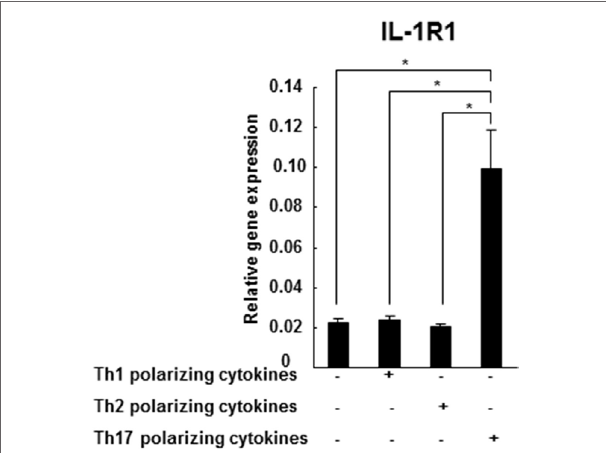
FigUre 2 | il-1r1 expression is higher in the in vitro -differentiated Th17 cells in comparison to Th1 and Th2 cultures . CD4 + CD45RA + cells were derived from three HCs and stimulated with plate-immobilized anti-CD3 and anti-CD28 mAb in a serum-free medium in the absence or presence of Th1, Th2, or Th17-polarizing cytokines. After 72 h, total RNA was extracted and gene expression of IL-1R1 and 18S was measured by RT-PCR. The results are expressed as relative gene expression normalized for 18S mRNA expression. Statistical analysis was performed using ANOVA. *** p <